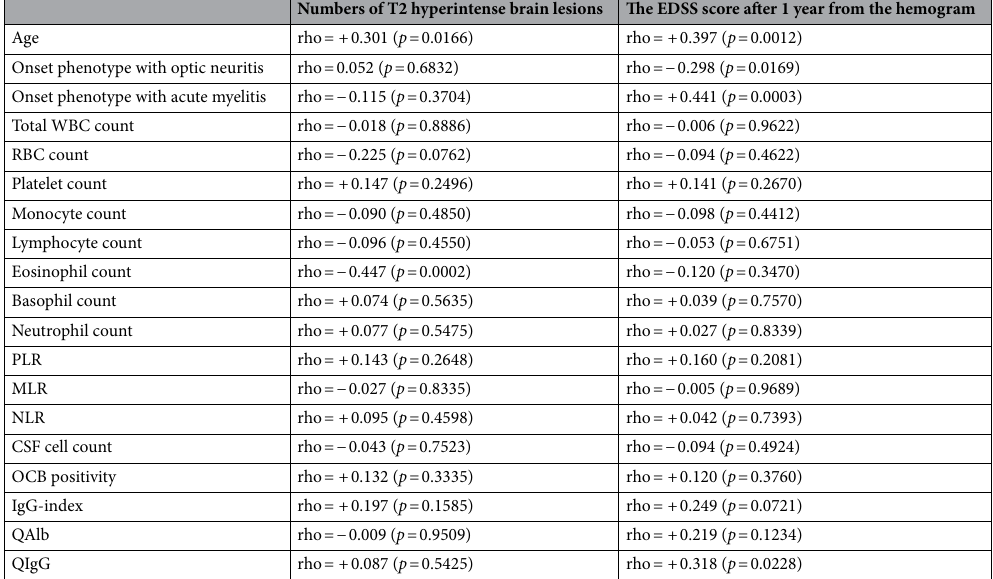
Table 3. Correlations between the evaluated variables and disease activity or severity in MS. Spearman’s correlation coefficients (rho) and the p values of the test of no correlation between the clinical manifestations and laboratory test data in MS are shown. CSF, cerebrospinal fluid; EDSS, Kurtzke Expanded Disability Status Scale; IgG, immunoglobulin G; MLR, monocyte-to-lymphocyte ratio; NLR, neutrophil-to-lymphocyte ratio; OCB, oligoclonal bands; PLR, platelet-to-lymphocyte ratio; QAlb, quotient of albumin; QIgG, quotient of immunoglobulin G; RBC, red blood cell; WBC, white blood